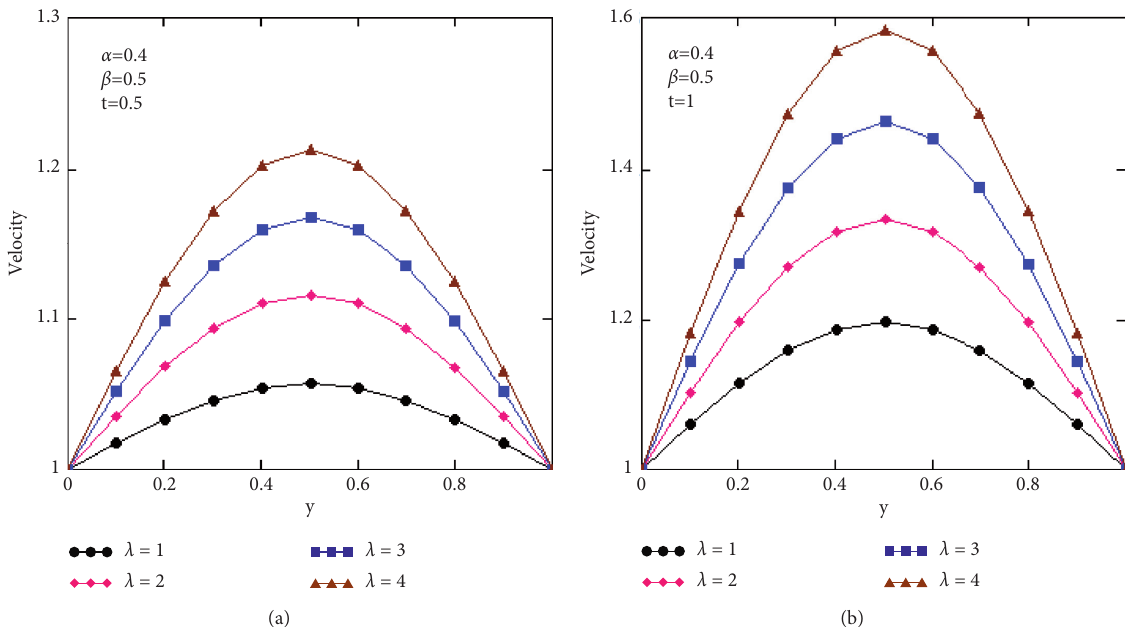
Figure 11: Profiles of dimensionless velocity versus y for variation of λ at altered values of time t , Gr � 5 , λ